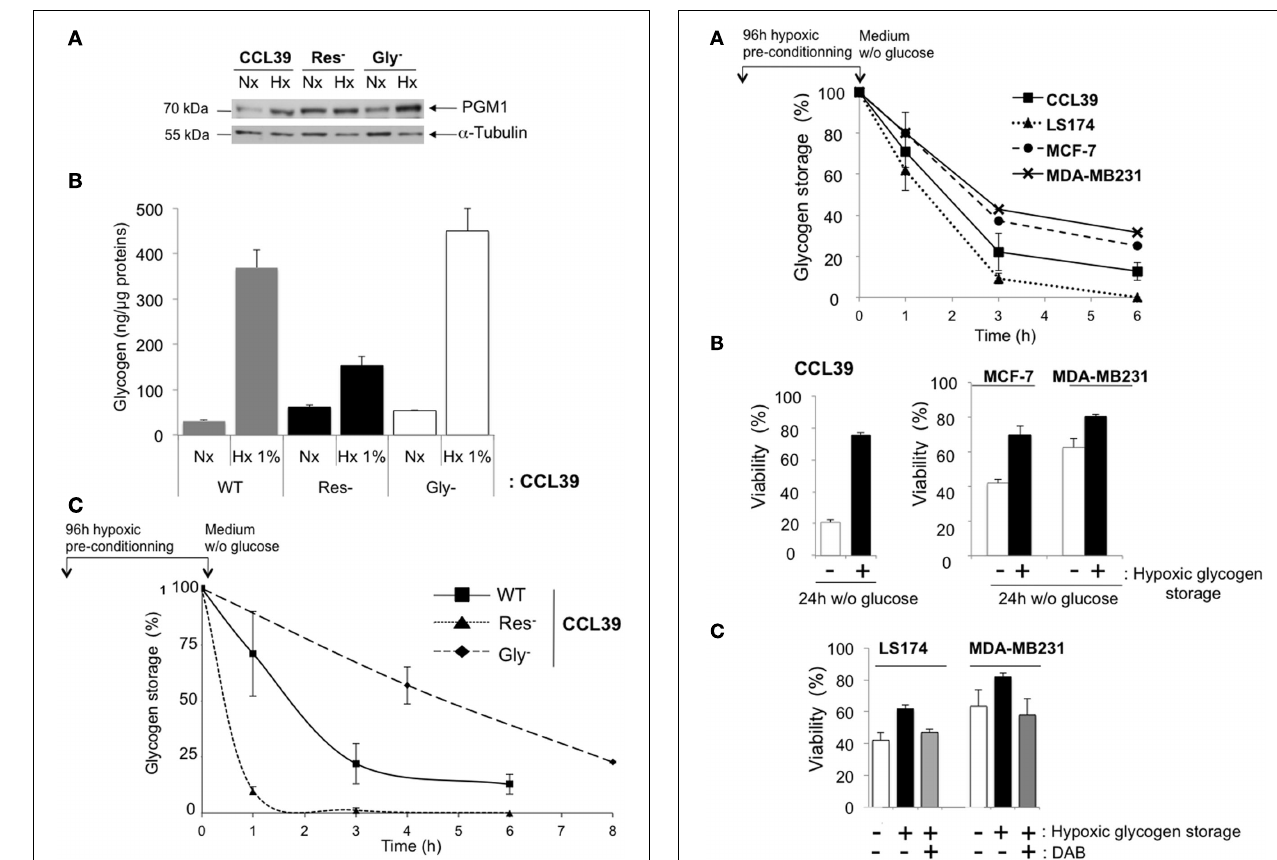
cells) to very high (RCC4 and MCF-7 cells) under normal